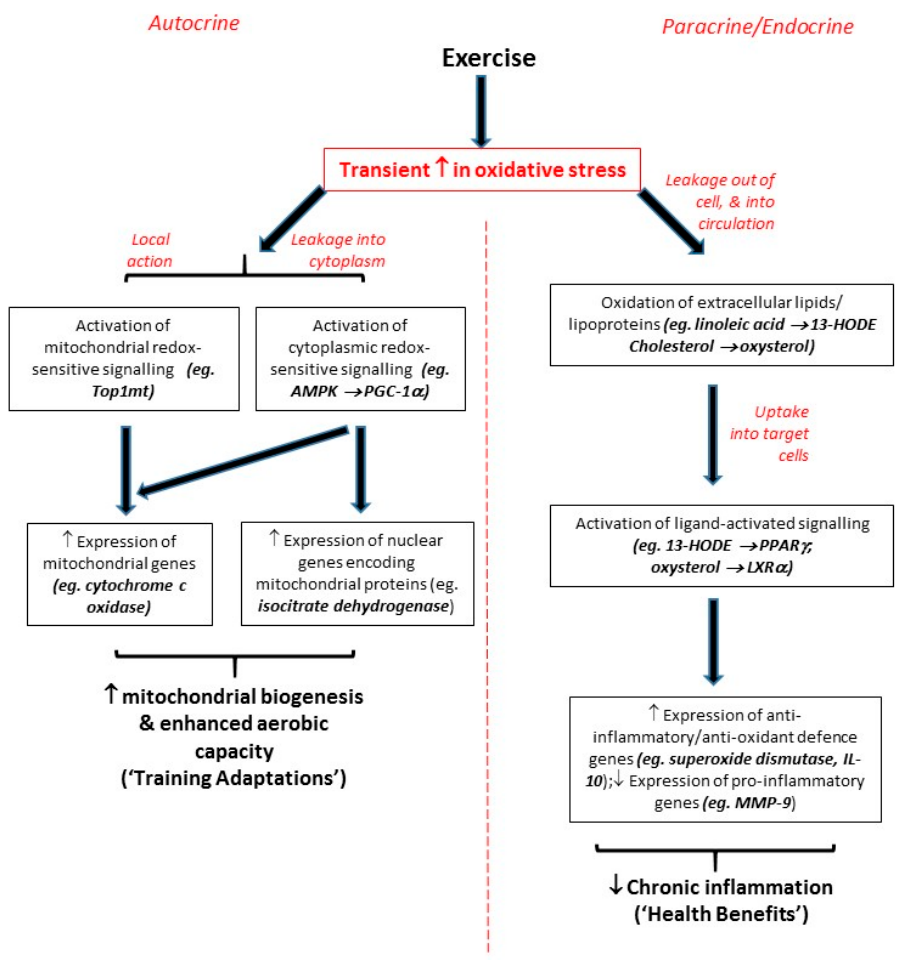
Figure 2. Flow-diagram summarising mechanisms by which exercise can trigger redox-sensitive signalling responses.